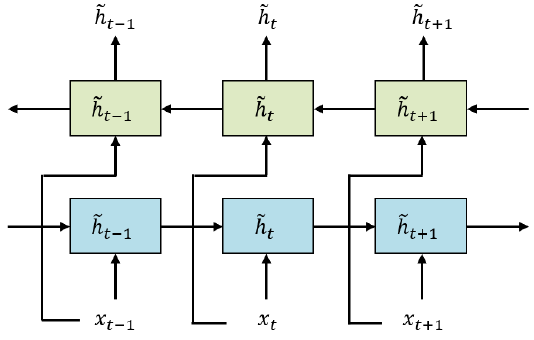
Figure 4. Structure of Bi-GRU